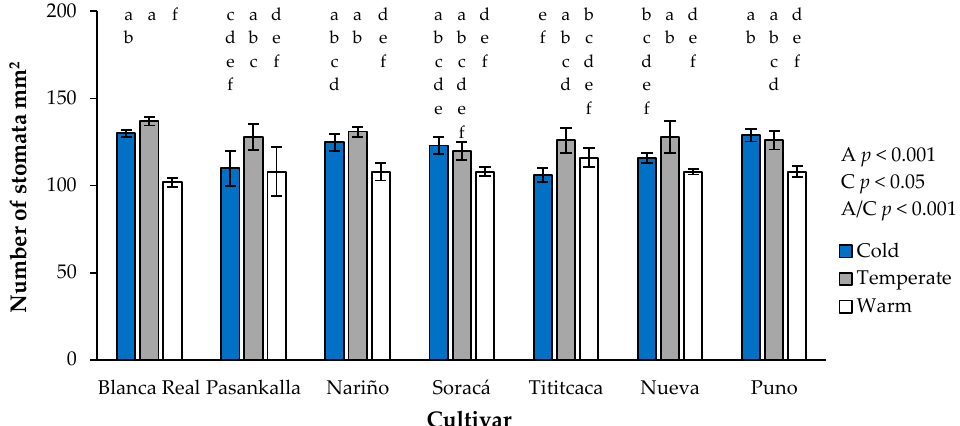
Figure 2. Stomatal density of different quinoa cultivars subjected to three altitude gradients. The bars indicate standard error. Different letters indicate significant differences. A: Altitudinal; C: Cultivar; A/C: Altitudinal/Cultivar.